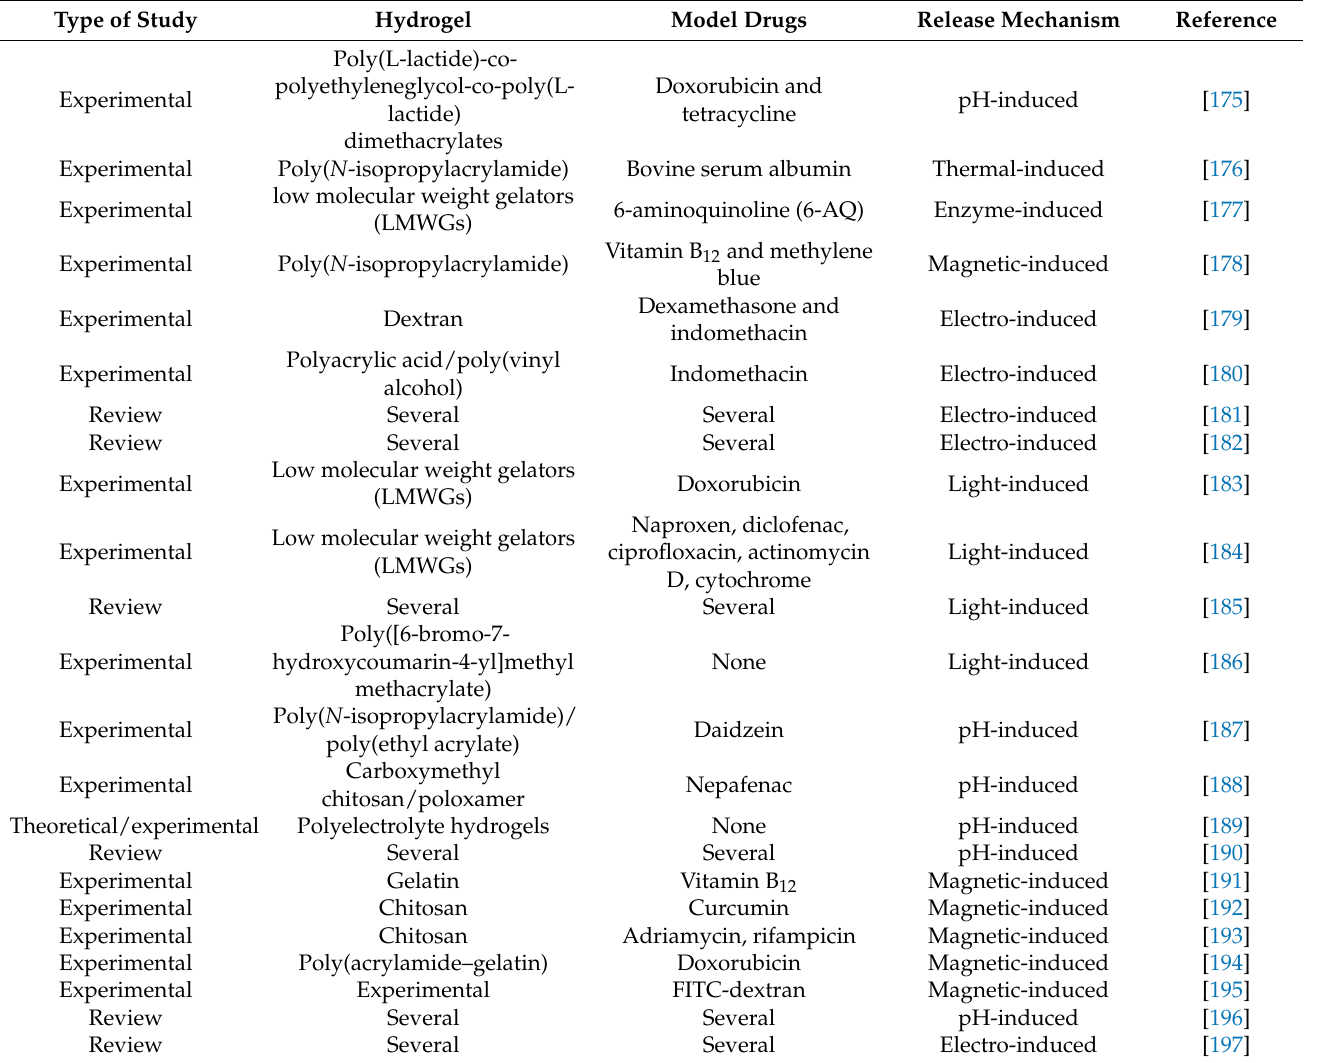
Table 4. A summary of stimuli responsive drug release studies of hydrogels in